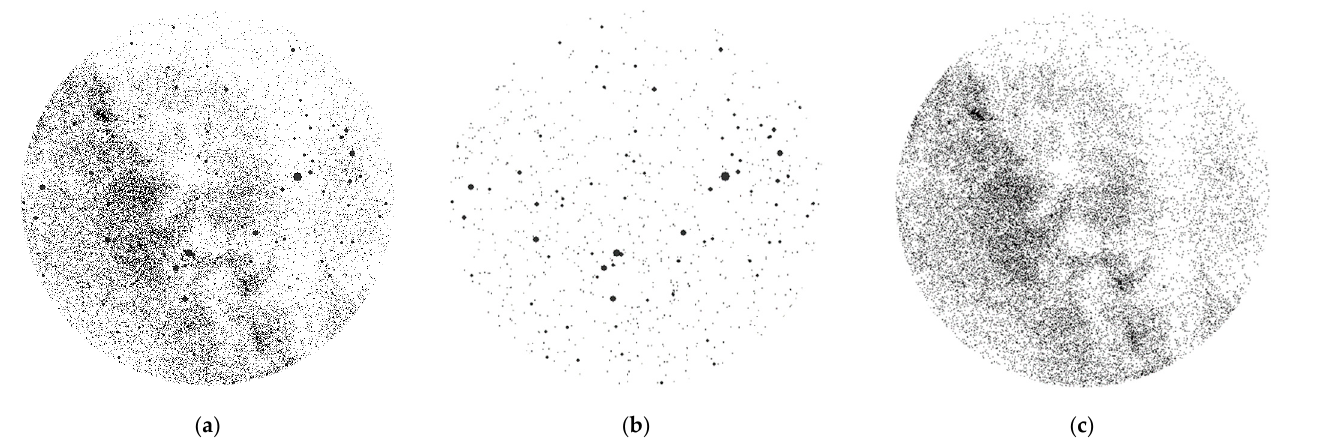
Figure 2. Examples of projected experimental stimuli. ( a ) Entire stimulus; ( b ) Stable stimulus (bright stars); ( c ) Variable stimulus (the Milky Way, faint stars).